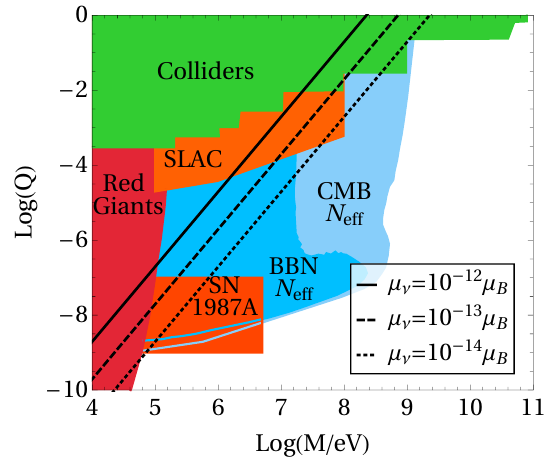
Figure 4 . Lines of constant (cid:22) (cid:23) for (cid:14)m (cid:23) = 0 : 2 eV in the plane of mass M and fractional charge Q of the millicharged particle. The constraints are coming from several observables and are taken from ref. [18]. See also the working group report and references therein